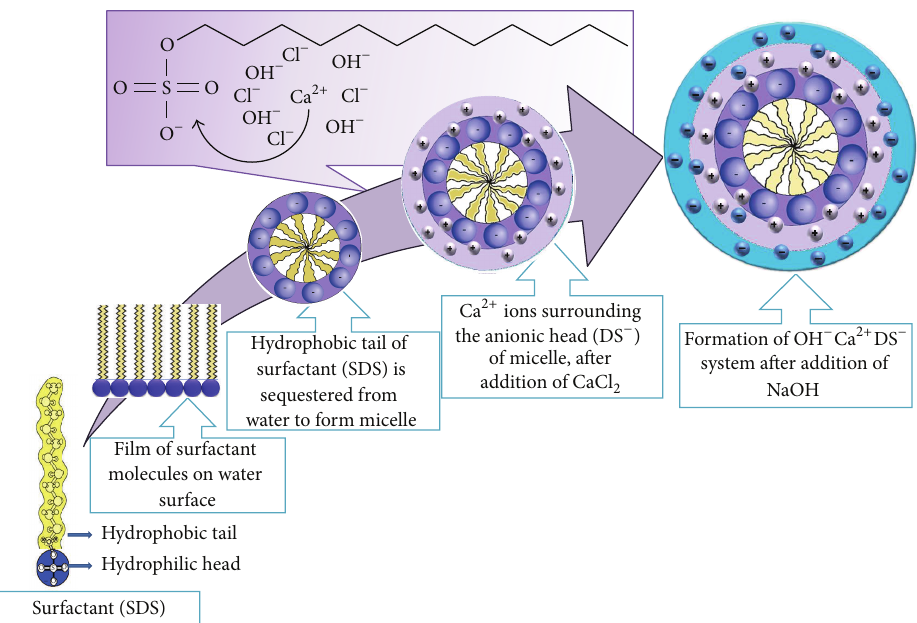
Figure 13: Mechanism of micelle assisted formation of OH − Ca 2+ DS − system.